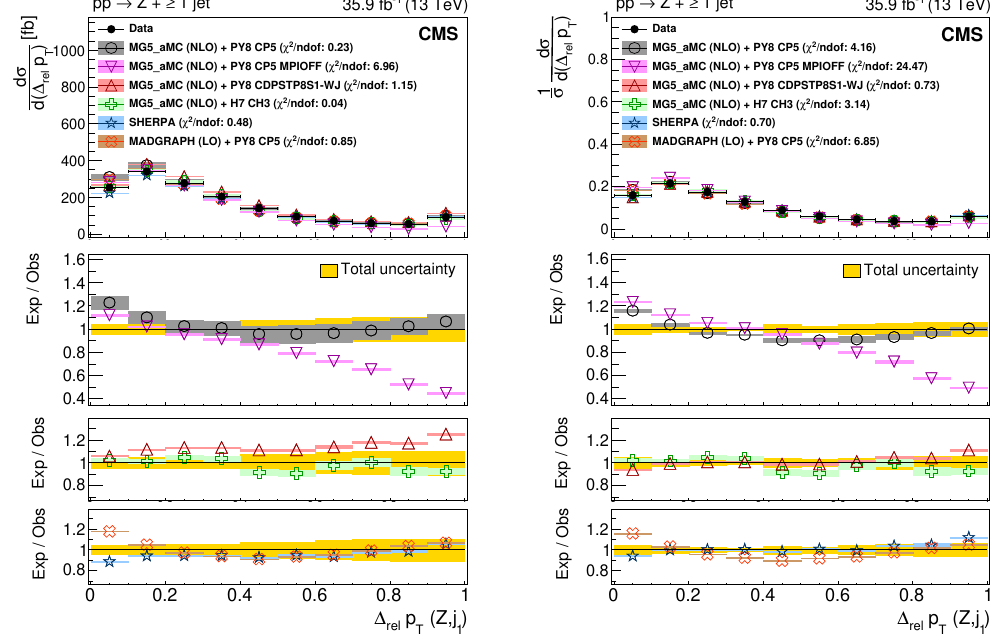
Figure 3 . Differential cross sections (left) and area-normalized distributions (right) as functions of the p imbalance between the Z boson and the leading jet for Z + ≥ 1 jet events. The uncertainties in T the predictions are shown as coloured bands around the theoretical predictions including statistical, PDF, scale, and tune uncertainties for the NLO MG5_aMC + pythia 8 (with CP5 tune) and the statistical uncertainty only for the LO MG5_aMC + pythia 8 (with CP5 tune), NLO MG5_aMC + pythia 8 (with CDPSTP8S1-WJ tune, CP5 tune with MPI-OFF), NLO MG5_aMC + herwig 7 (with tune CH3), and sherpa predictions. In the top panel, the vertical bars on the data points represent statistical uncertainties, whereas in the bottom panels, the total uncertainty in data is indicated by the solid yellow band centred at 1. In the legend, the χ 2 per degree of freedom is given to quantify the goodness of fit of the model to the